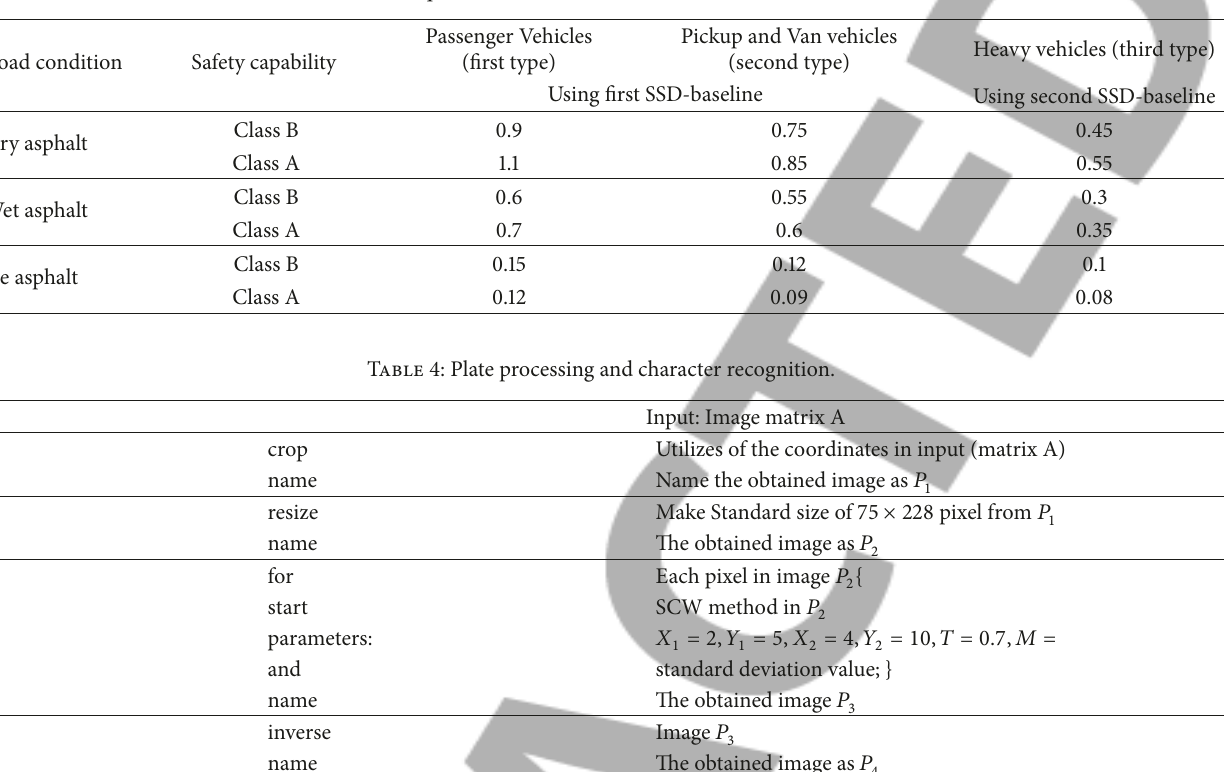
Table 3: The friction coefficient quantities for different vehicle classifications in different road conditions.